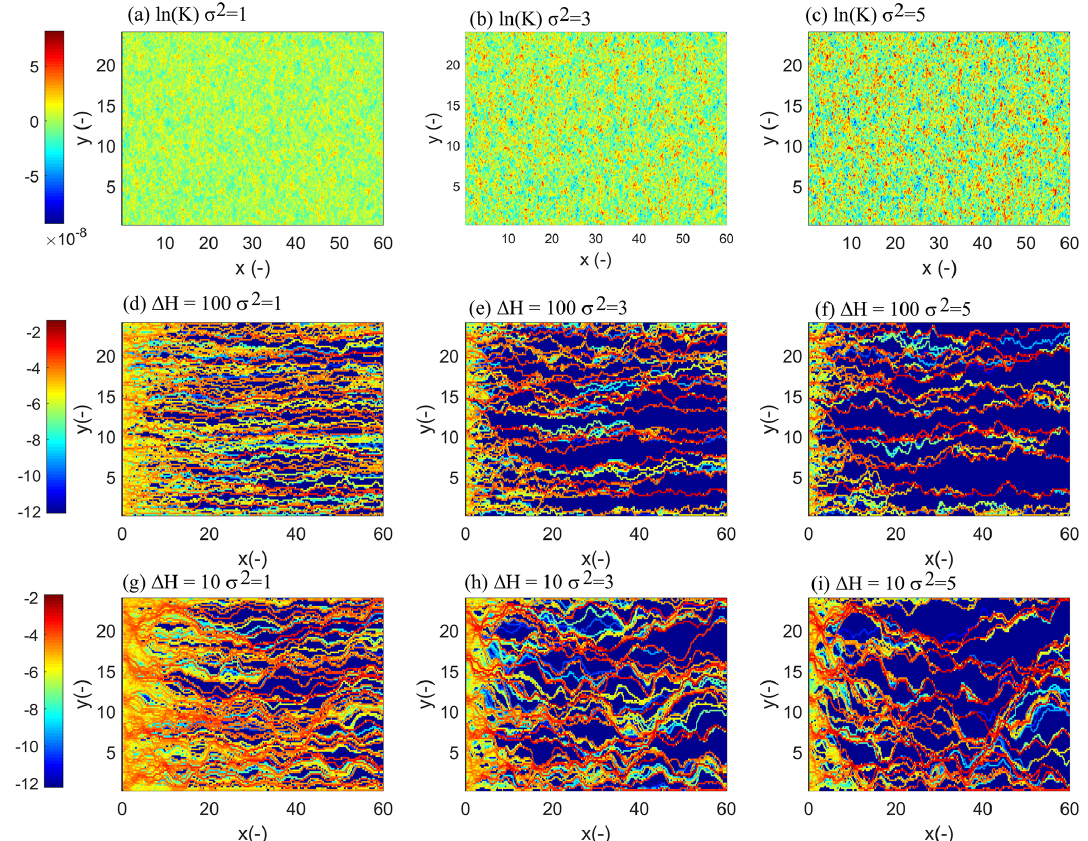
Figure 1. Examples of (a) – (c) ln( K ) for variances σ 2 = 1, 3, and 5, respectively, and the corresponding cumulative number of particles that visited a grid cell in the simulation domain normalized with the total number of N particles, for the head differences (d–f) (cid:49)H = 100 and (g–i) 10. This corresponds to Péclet numbers of 597 and 59.7,